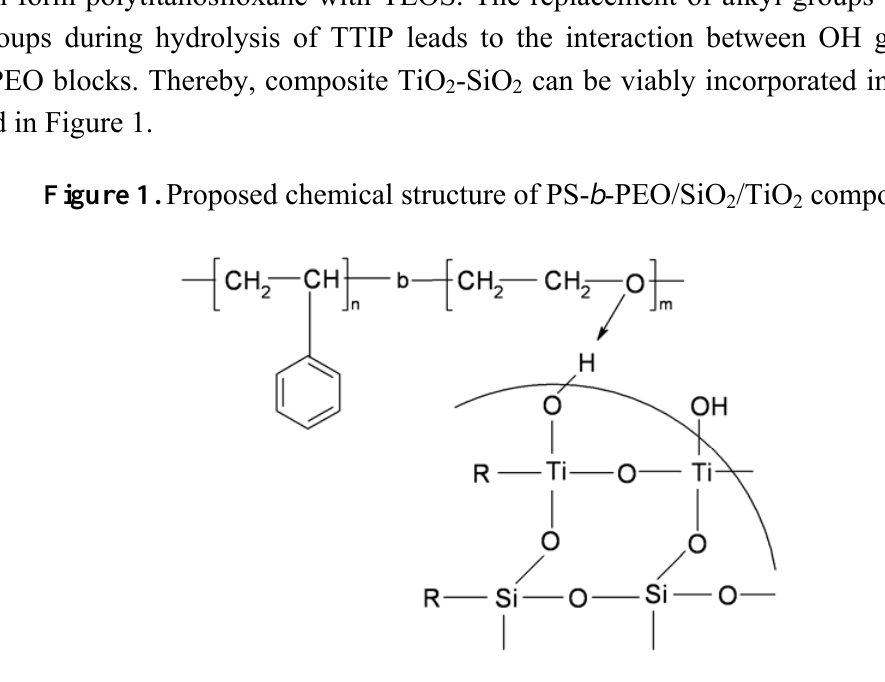
Figure 1. Proposed chemical structure of PS- b -PEO/SiO